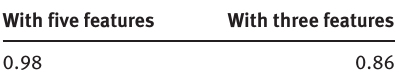
Table 6: Average Process Time (in